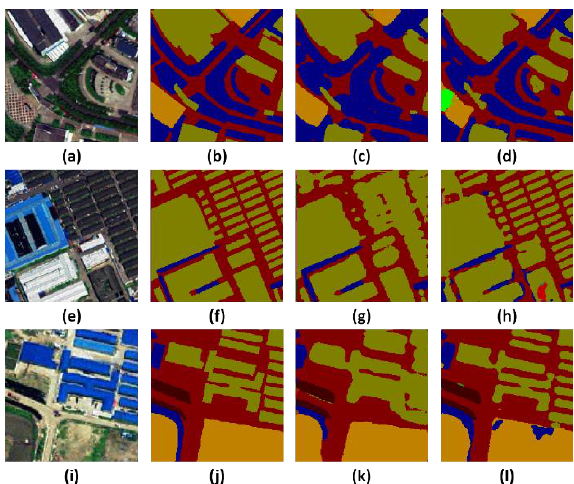
Figure 4. Segmentation effect of FCN and U-Net. It shows three examples of FCN and U-Net segmentation effect comparison. ( a,e,i ) are the input images. ( b,f,j ) are corresponding ground truth of the images. ( c,g,k ) are segmentation maps of FCN. ( d,h,l ) are segmentation maps of U-Net. It was found that FCN performed better at segmenting large objects, while smaller objects were easier to aggregate into blocks, so FCN was more suitable for large-scale segmentation. U-Net worked well when smaller objects were segmented but tended to misclassify some small fragments of the large-scale objects when it was being segmented, so U-Net was more suitable for small-scale segmentation.